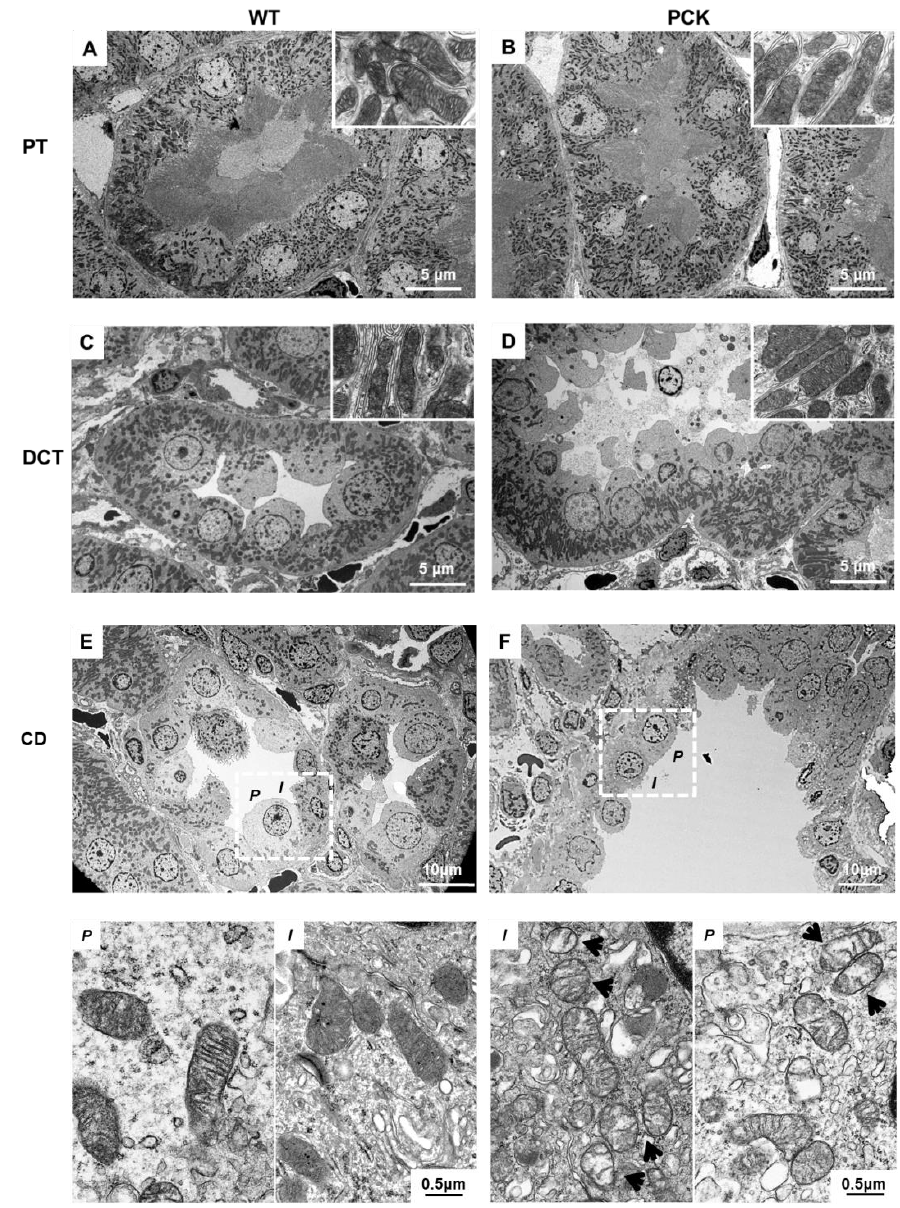
Figure 2. PKD is associated with mitochondrial structural abnormalities in cyst-lining tubular cells. Transmission electron micrograph (TEM) displaying representative tubular structures from WT (left column) and PCK (right column) kidneys at 4 weeks. In PCK kidneys, the cells of proximal tubules ( B ) had normal appearance and were characterized by a tall brush border and extensive invaginations of the basolateral plasma membrane containing abundant elongated mitochondria ( × 2500 and × 80,000) compared to WT kidneys ( A ). Similarly, the cells from distal tubules in PCK animals ( D ) presented numerous long mitochondria arranged between the foldings of the basal lamina that resembled normal appearing mitochondria as in WT kidneys ( C ). On the other hand, mitochondria from CD